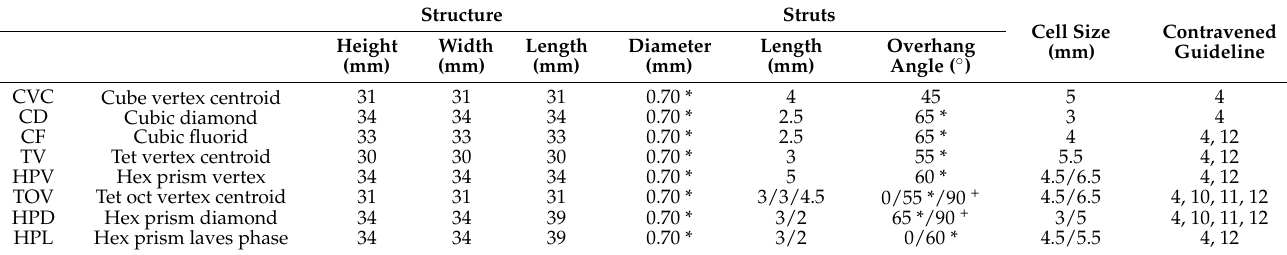
Table 4. Geometric features of tested unit cells and lattice structures, and contravened FFF